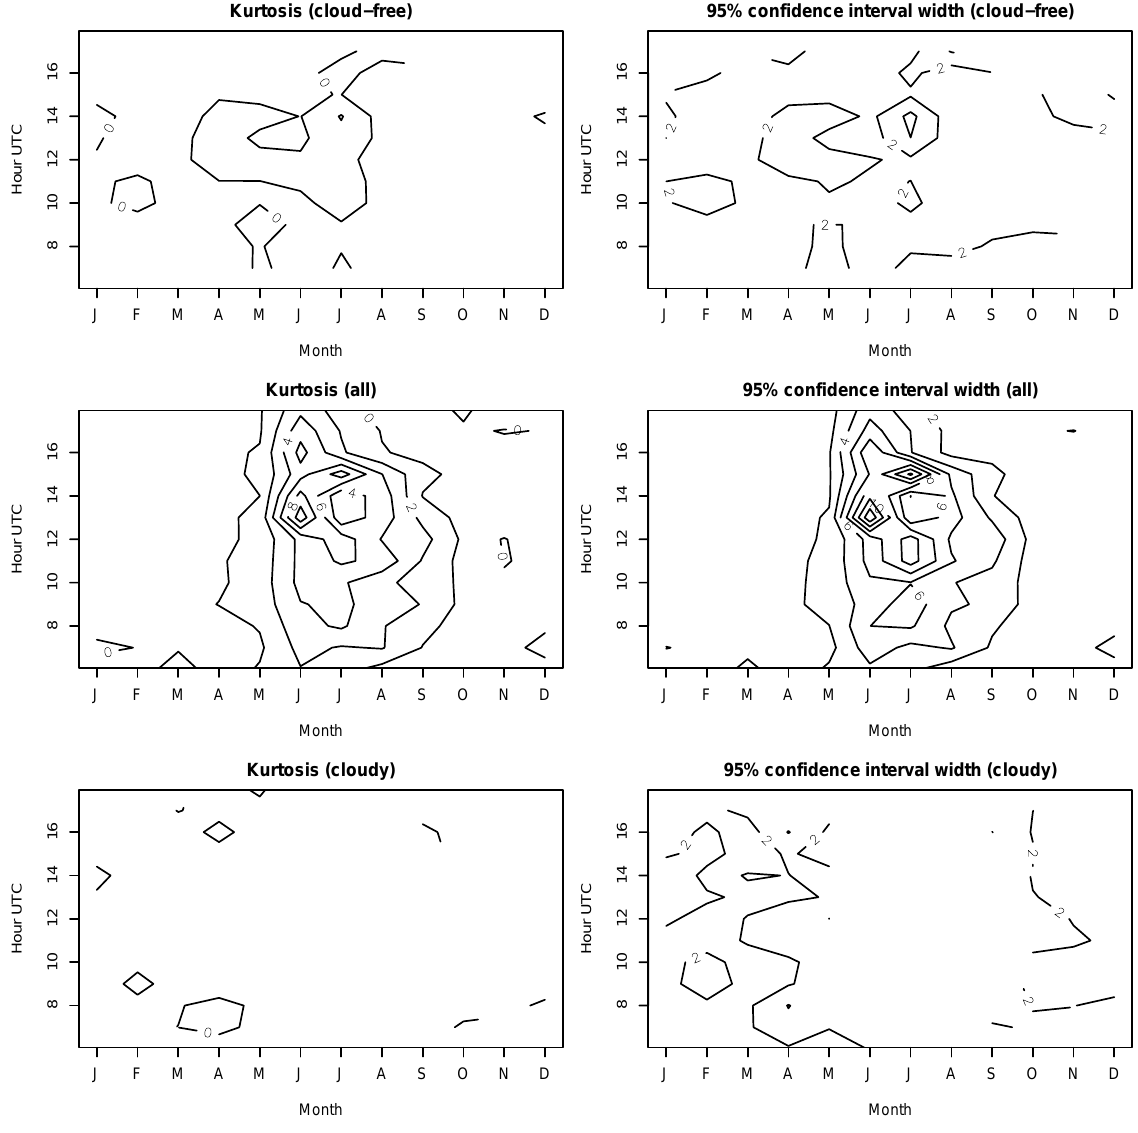
Fig. 14. Isolines of the kurtosis of hourly ultraviolet erythemal